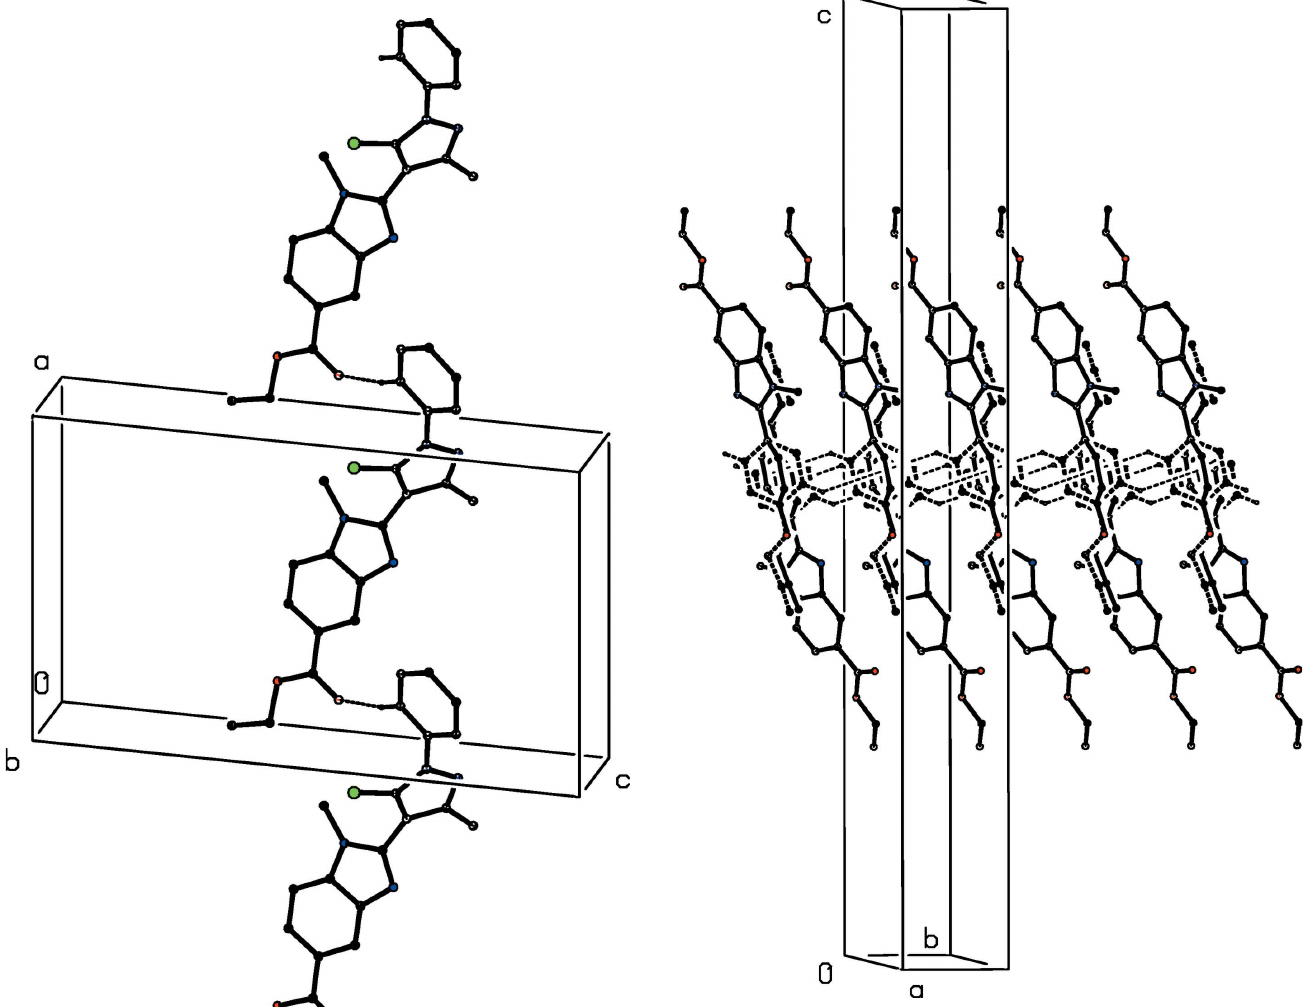
Figure 8 Part of the crystal structure of compound (I) showing the idealized ribbon along [010] that would result if all the hydrogen-bond donors and acceptors had unit occupancy. The disorder components are drawn using full and broken lines. Hydrogen bonds are drawn as dashed lines and, for the sake of clarity, the H atoms not involved in the motif shown have been